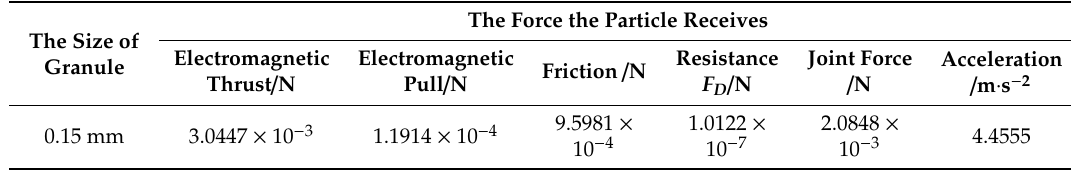
Table 4. Various forces acting on magnetic particles.